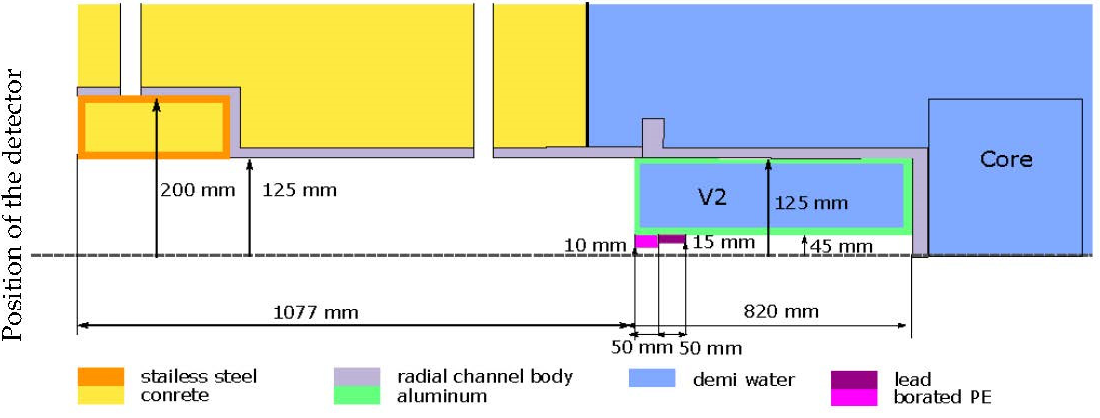
Figure 4. Drawing of the radial beamline with water plug (V2) and pinhole (Pb and PE).